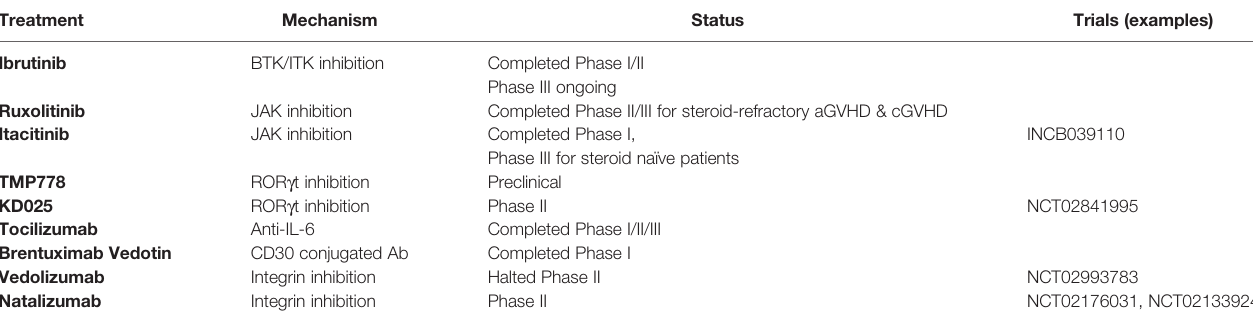
TABLE 2 | Summary of recent novel small molecule treatments for